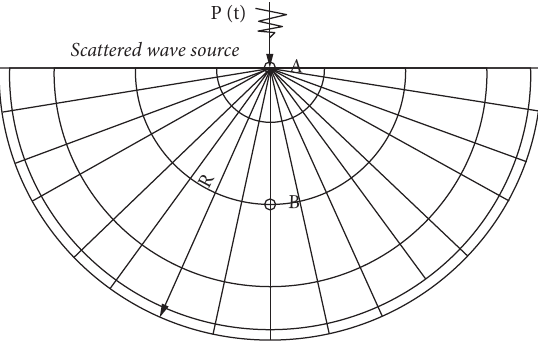
Figure 6: 2D half-space